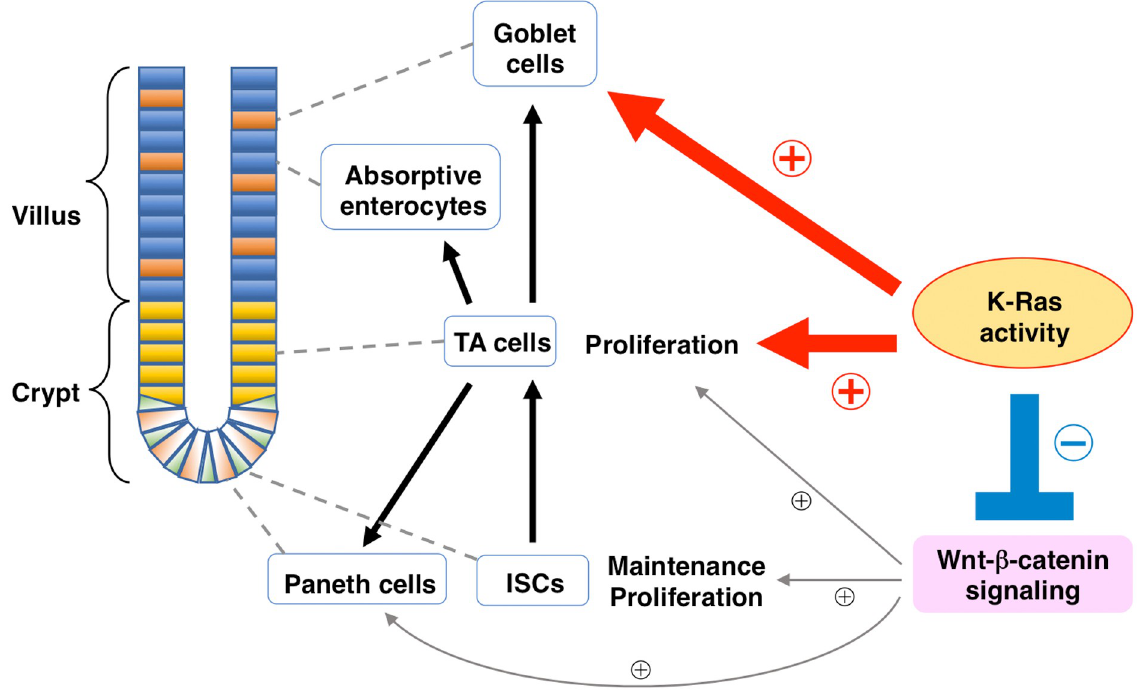
Fig 5. Regulation by K-Ras activity of IEC homeostasis. The Ras signaling pathway promotes both IEC proliferation and the differentiation of goblet cells. In contrast, the Ras activity primarily downregulates Wnt– β -catenin signaling and negatively regulates in the number of Paneth cells as well as of ISCs at the crypt